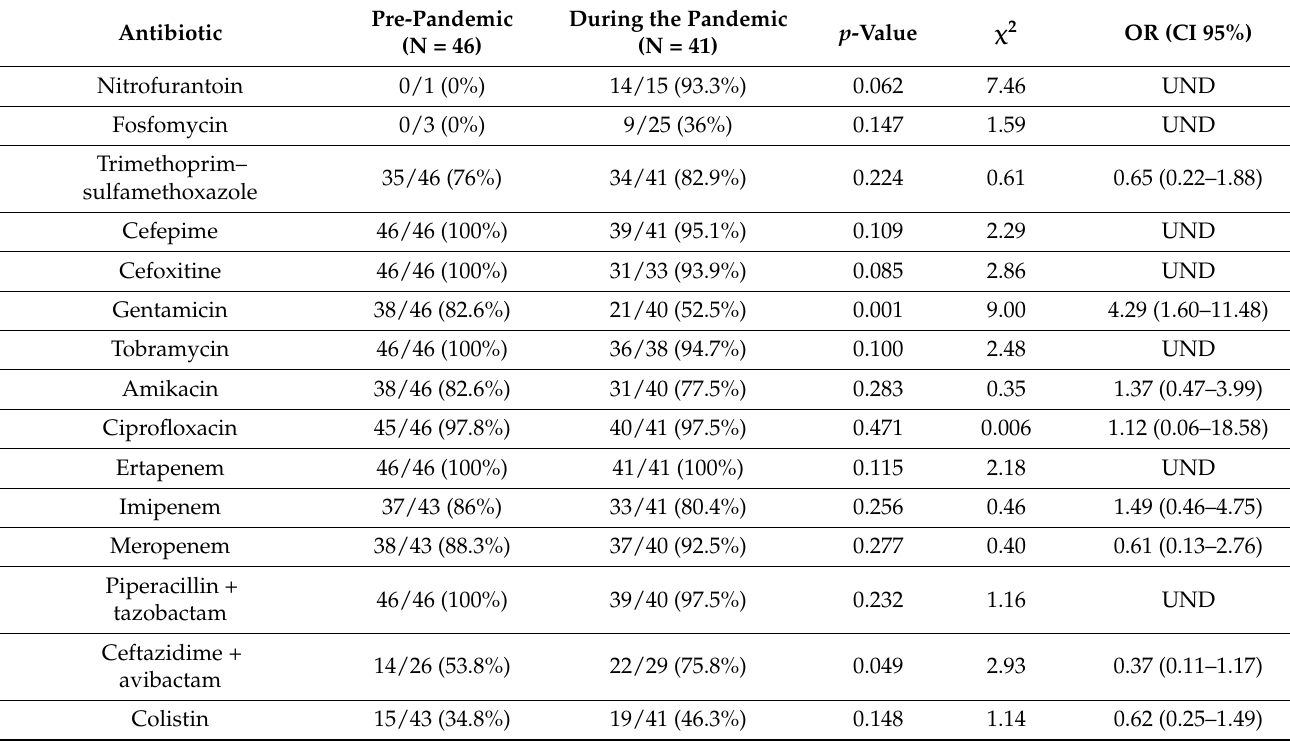
Table 3. Antibiotic resistance rates: before and after the onset of the COVID-19 pandemic.